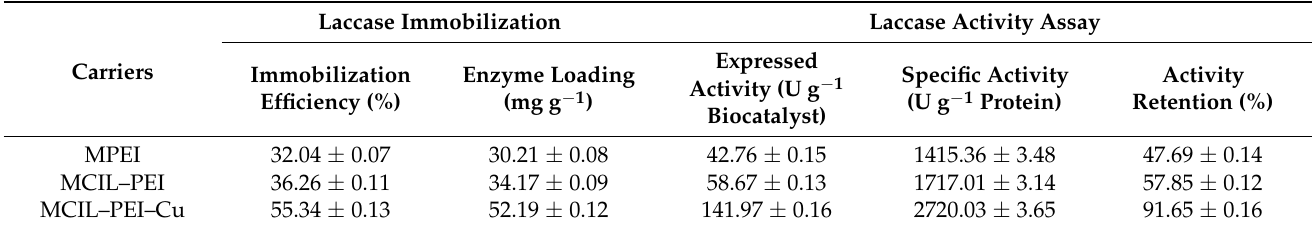
Table 1. Results of laccase immobilization a .